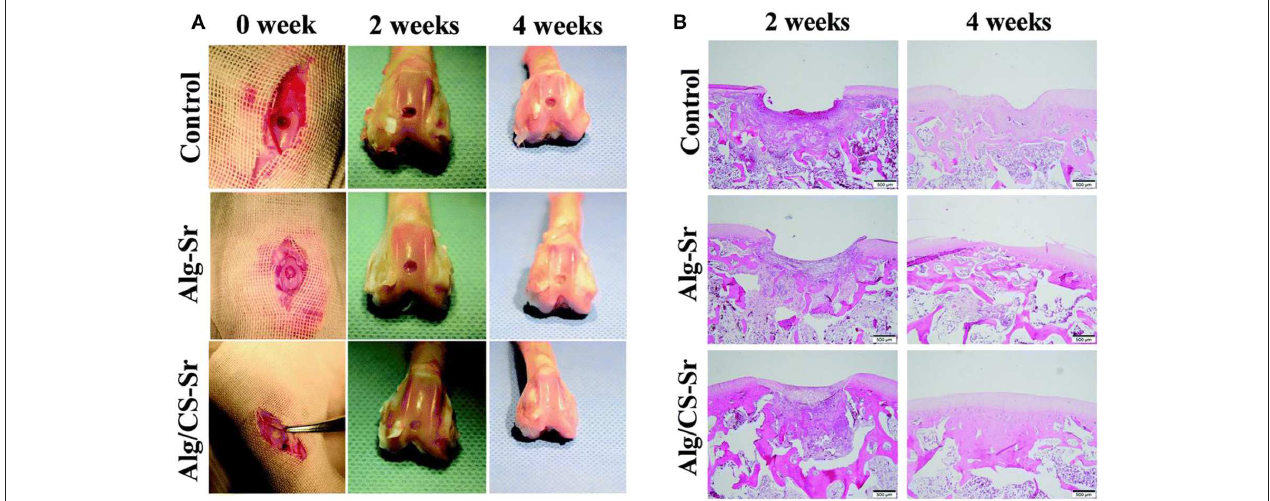
FIGURE 10 | ALG hydrogel aiding cartilage defect repair in a rabbit model: (A) photographs of knee joints in the control group and the ALG hydrogel group at the 0, 2, and 4 weeks after post-operation. (B) H&E staining of cartilage defect. Reproduced from Ma et al. (2019) with permission from Copyright 2019 Royal Society of